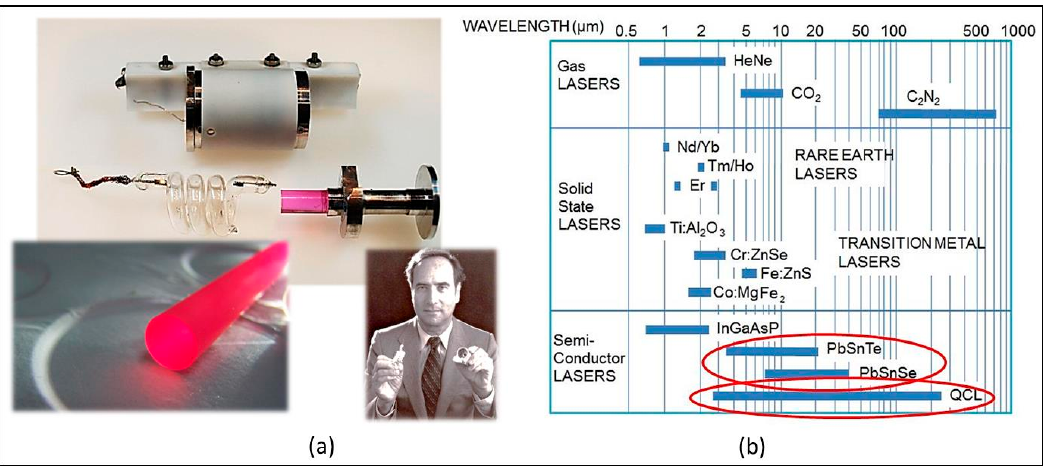
Figure 8. ( a ) Theodore Maiman with the first Ruby laser demonstrated in 1960 at the Hughes Research Labs [37]; ( b ) Some of the available direct laser sources in the IR and THz region [38].